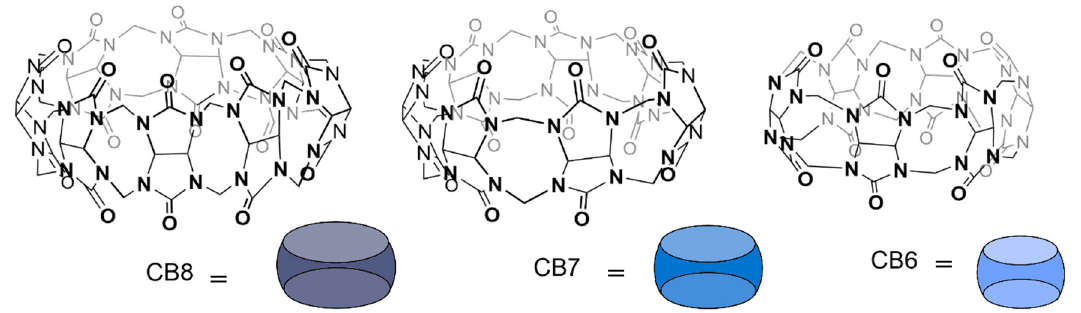
Figure 6. Structure of the Cucurbit[n]uril (CBn) receptors and corresponding schemes that will be used for illustration purposes throughout this review.